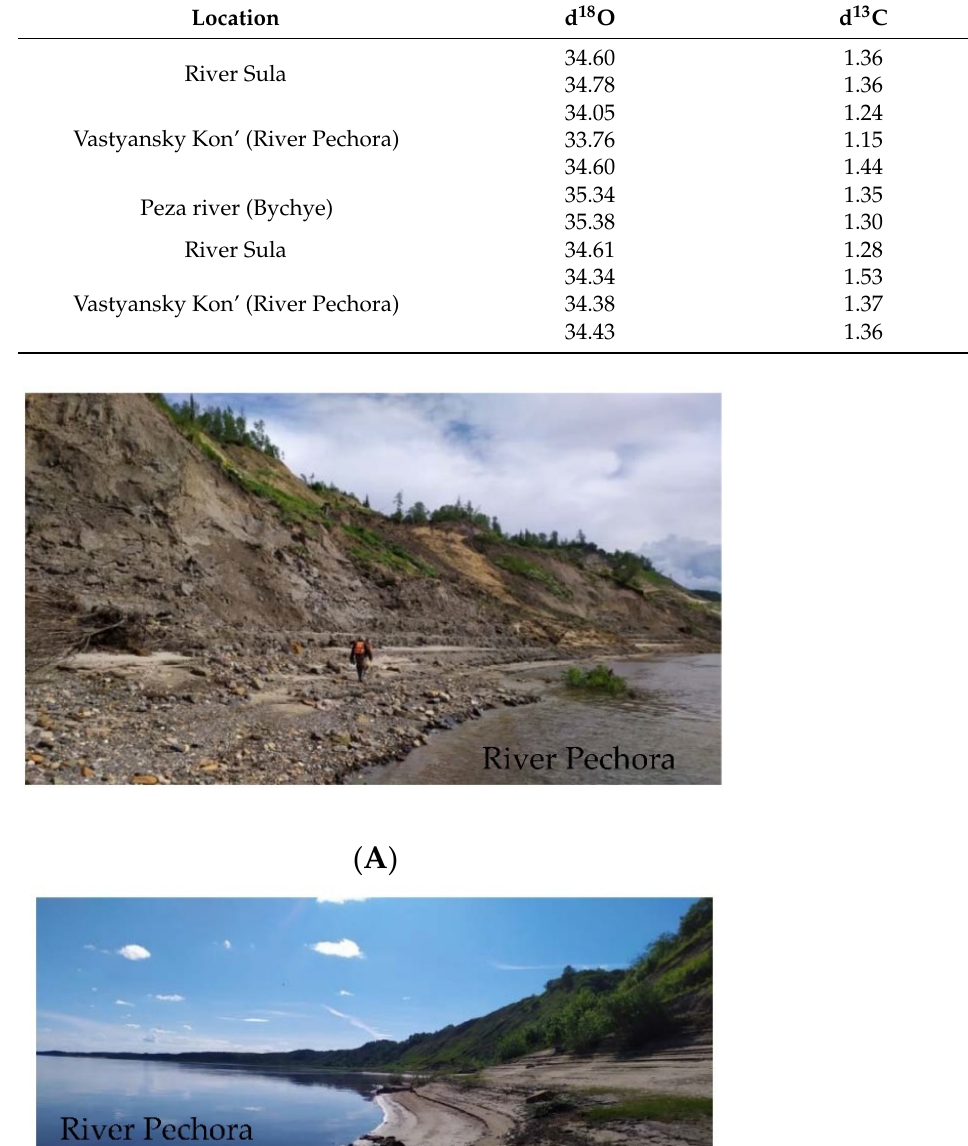
Table 2 and Figure 8 show the measurements of stable isotopes δ 13 C and δ 18 O in carbonate shells of mollusks. The data show that the ratio of these stable isotopes allows them to be divided by location according to the groups—Vastyansky Kon’, Sula River, and Peza River. Table 2. Variations in δ 13 C and δ 18 O isotopes in the studied fossil shells (average isotopic measure- ments in 5 shells) of the European North (‰).